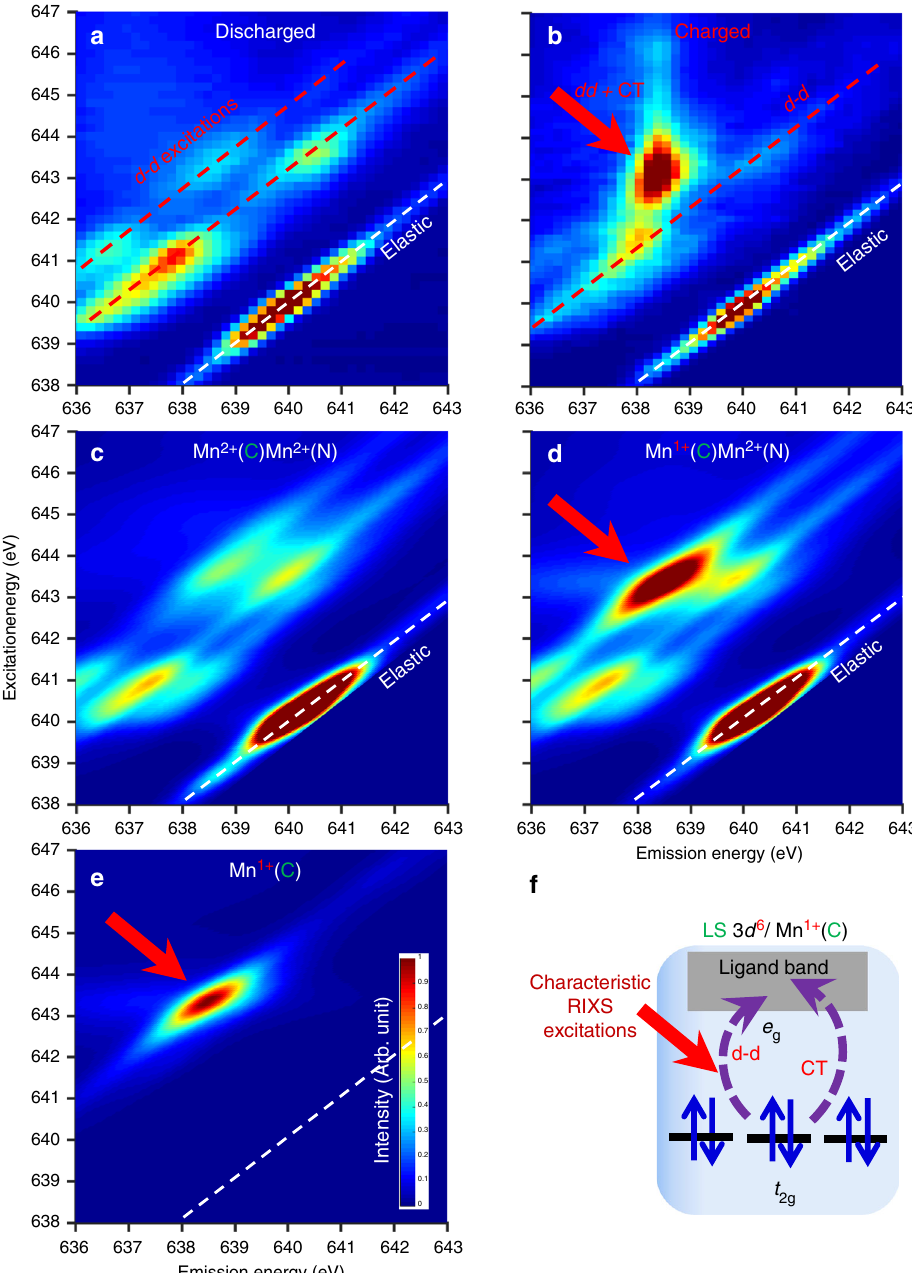
Fig. 4 Direct probe of Mn 1 + by soft X-ray RIXS maps. a , b Mn L 3 -edge RIXS maps on MnHCMn electrodes at the discharged (oxidized) and charged (reduced) states, respectively. c , d Corresponding RIXS calculations with the nominal Mn valence marked on the maps. The strong RIXS intensity of the charged electrode (red arrow) is reproduced only with Mn 1 + at the C-coordinated site, as shown in e . Calculation results with other con fi gurations are shown in Supplementary Fig. 15. f A schematic to explain the characteristic Mn 1 + RIXS feature, which fi ngerprints the excitations from the fully occupied t 2g to the nominally vacant e g orbitals ( d-d ) and delocalized ligand band states (CT) of a low-spin 3 d 6 state, i.e., Mn 1 +